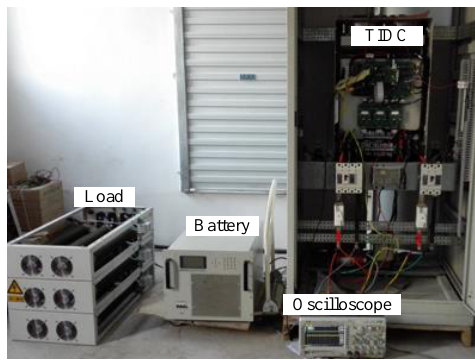
Figure 9. Experiment platform.